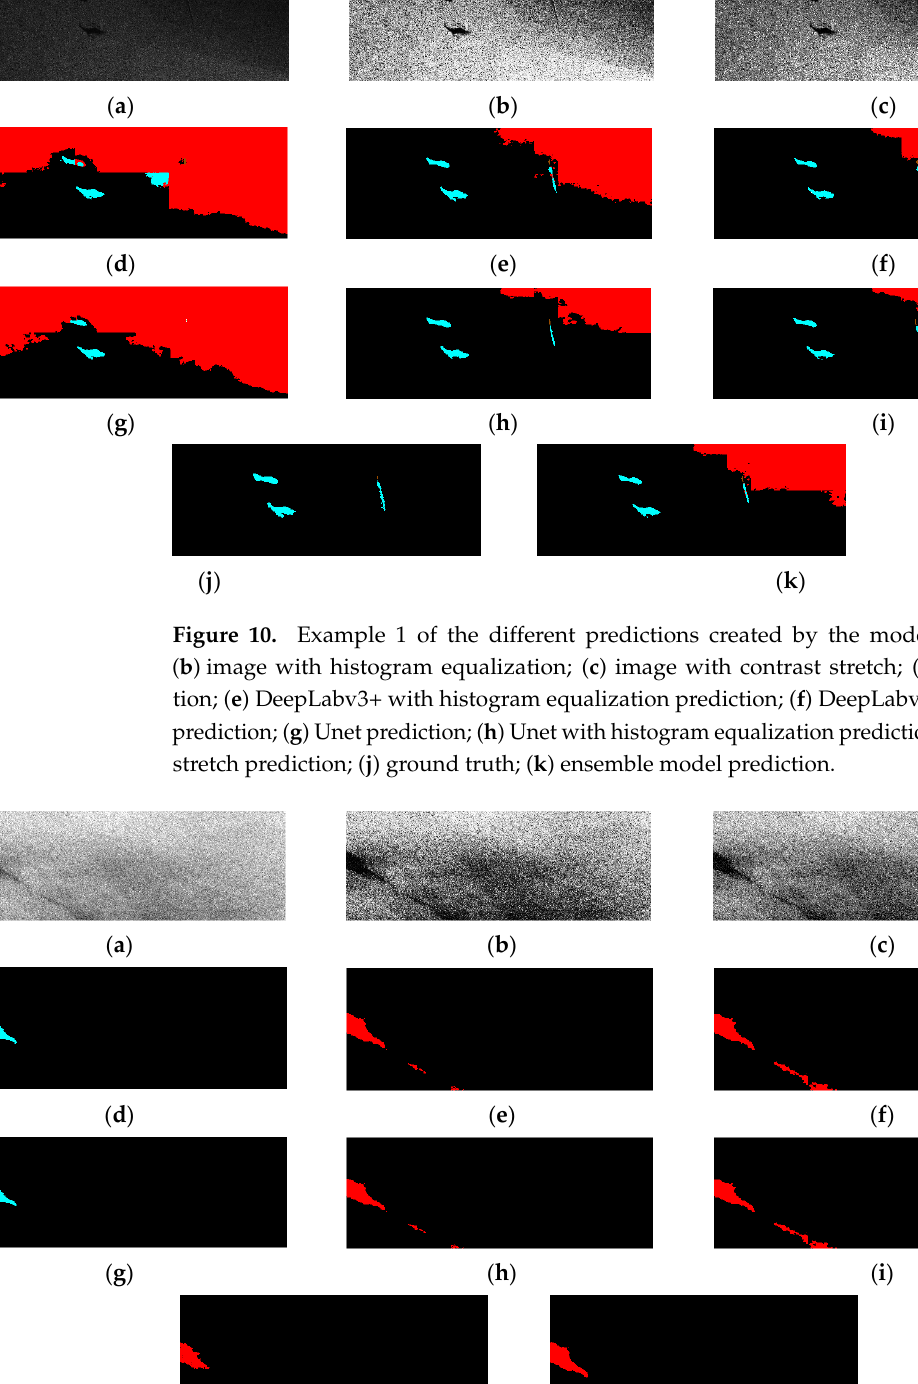
( k ) Figure 12. Example 3 of the different predictions created by the models: ( a ) original image; ( b ) image with histogram equalization; ( c ) image with contrast stretch; ( d ) DeepLabv3+ prediction; ( e ) DeepLabv3+ with histogram equalization prediction; ( f ) DeepLabv3+ with contrast stretch predic- tion; ( g ) Unet prediction; ( h ) Unet with histogram equalization prediction; ( i ) Unet with contrast stretch prediction; ( j ) ground truth; ( k ) ensemble model prediction.